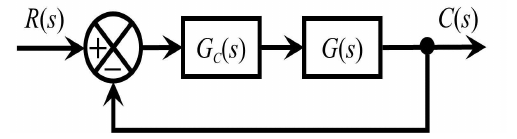
Fig. 1: Feedback linear continuous-time interval control